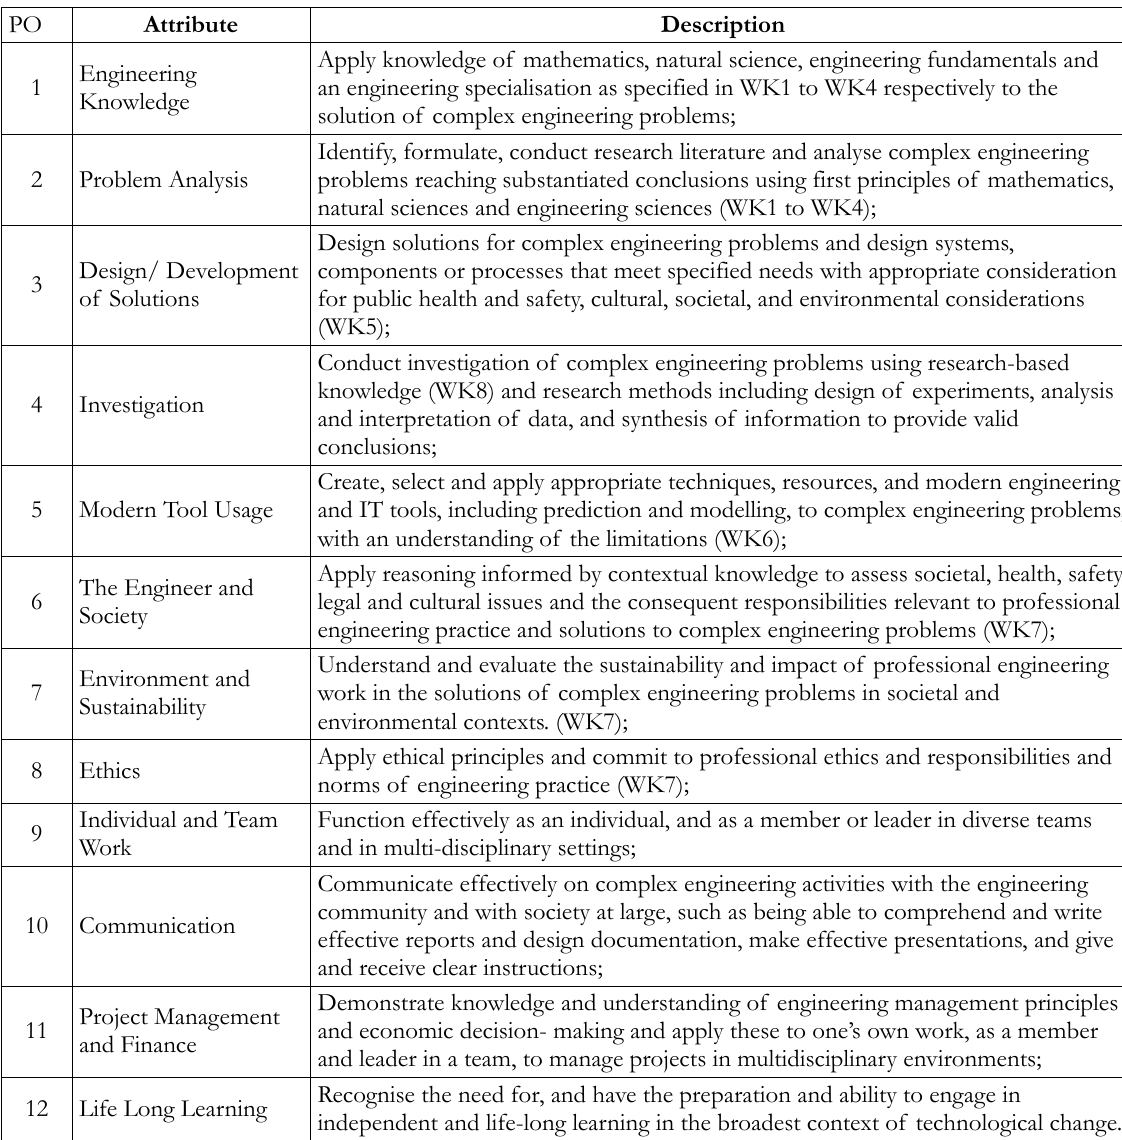
Table 1. Graduate attribute profiles for WA. (Accord,